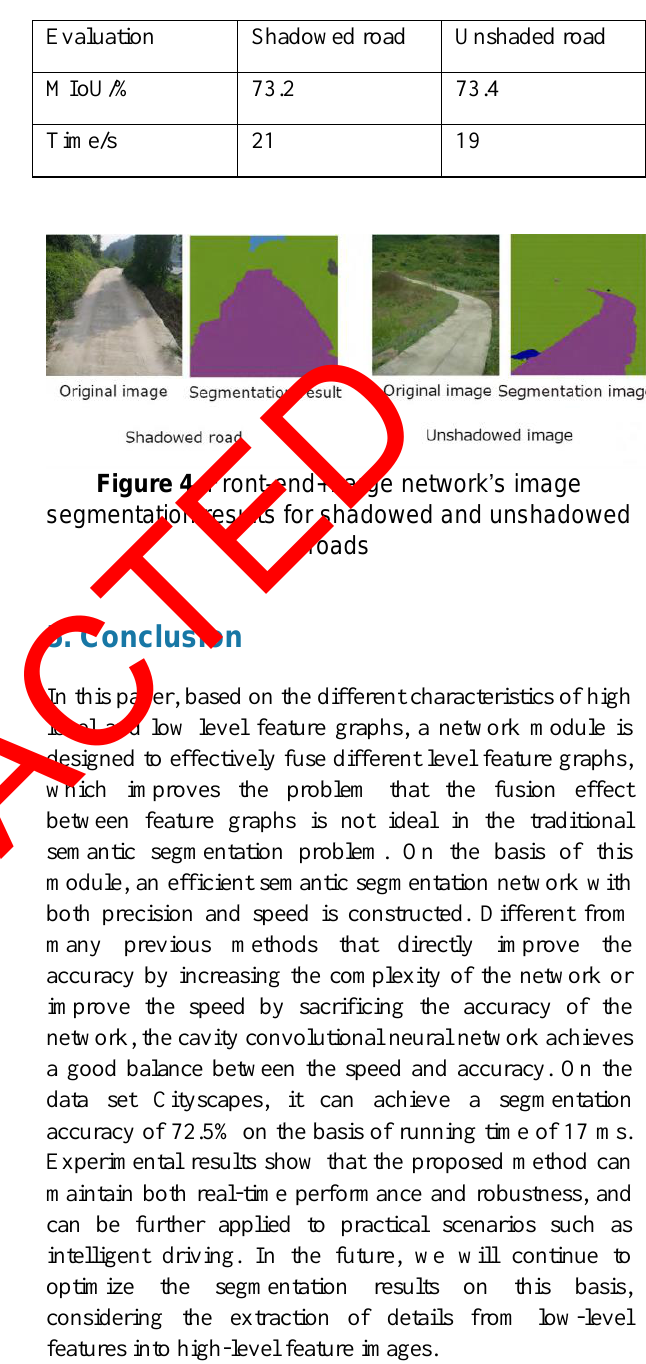
Table 4. Test results of shadowed and unshadowed roads